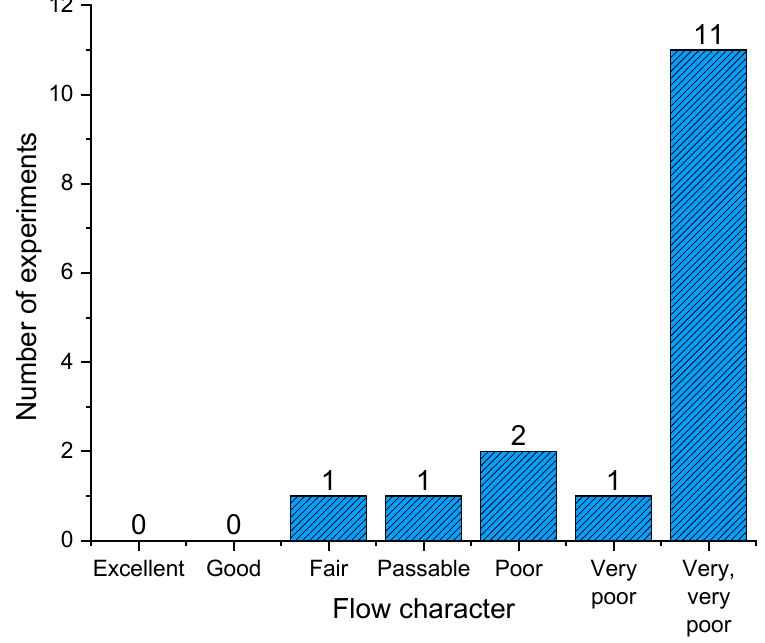
Figure 10. Dry emulsion spray dried powders according to flow character derived from HR val- ues.